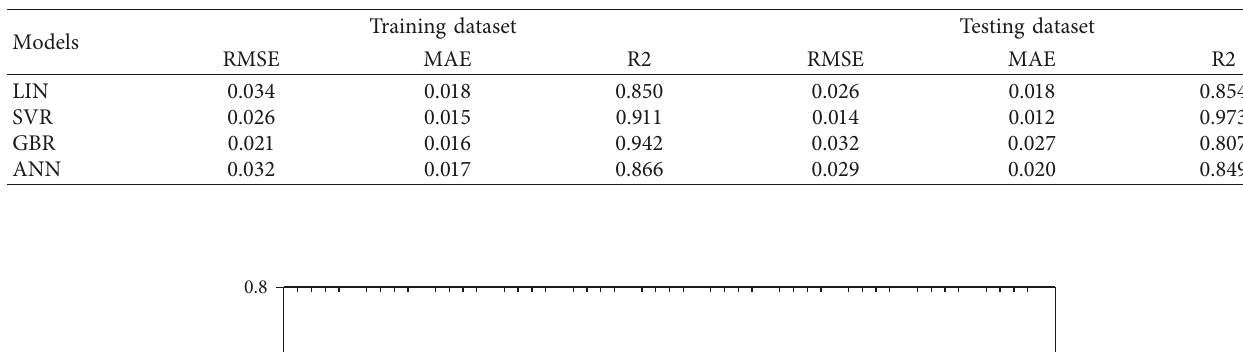
Table 5: Performance of ML models for Ra prediction on the training and testing datasets.